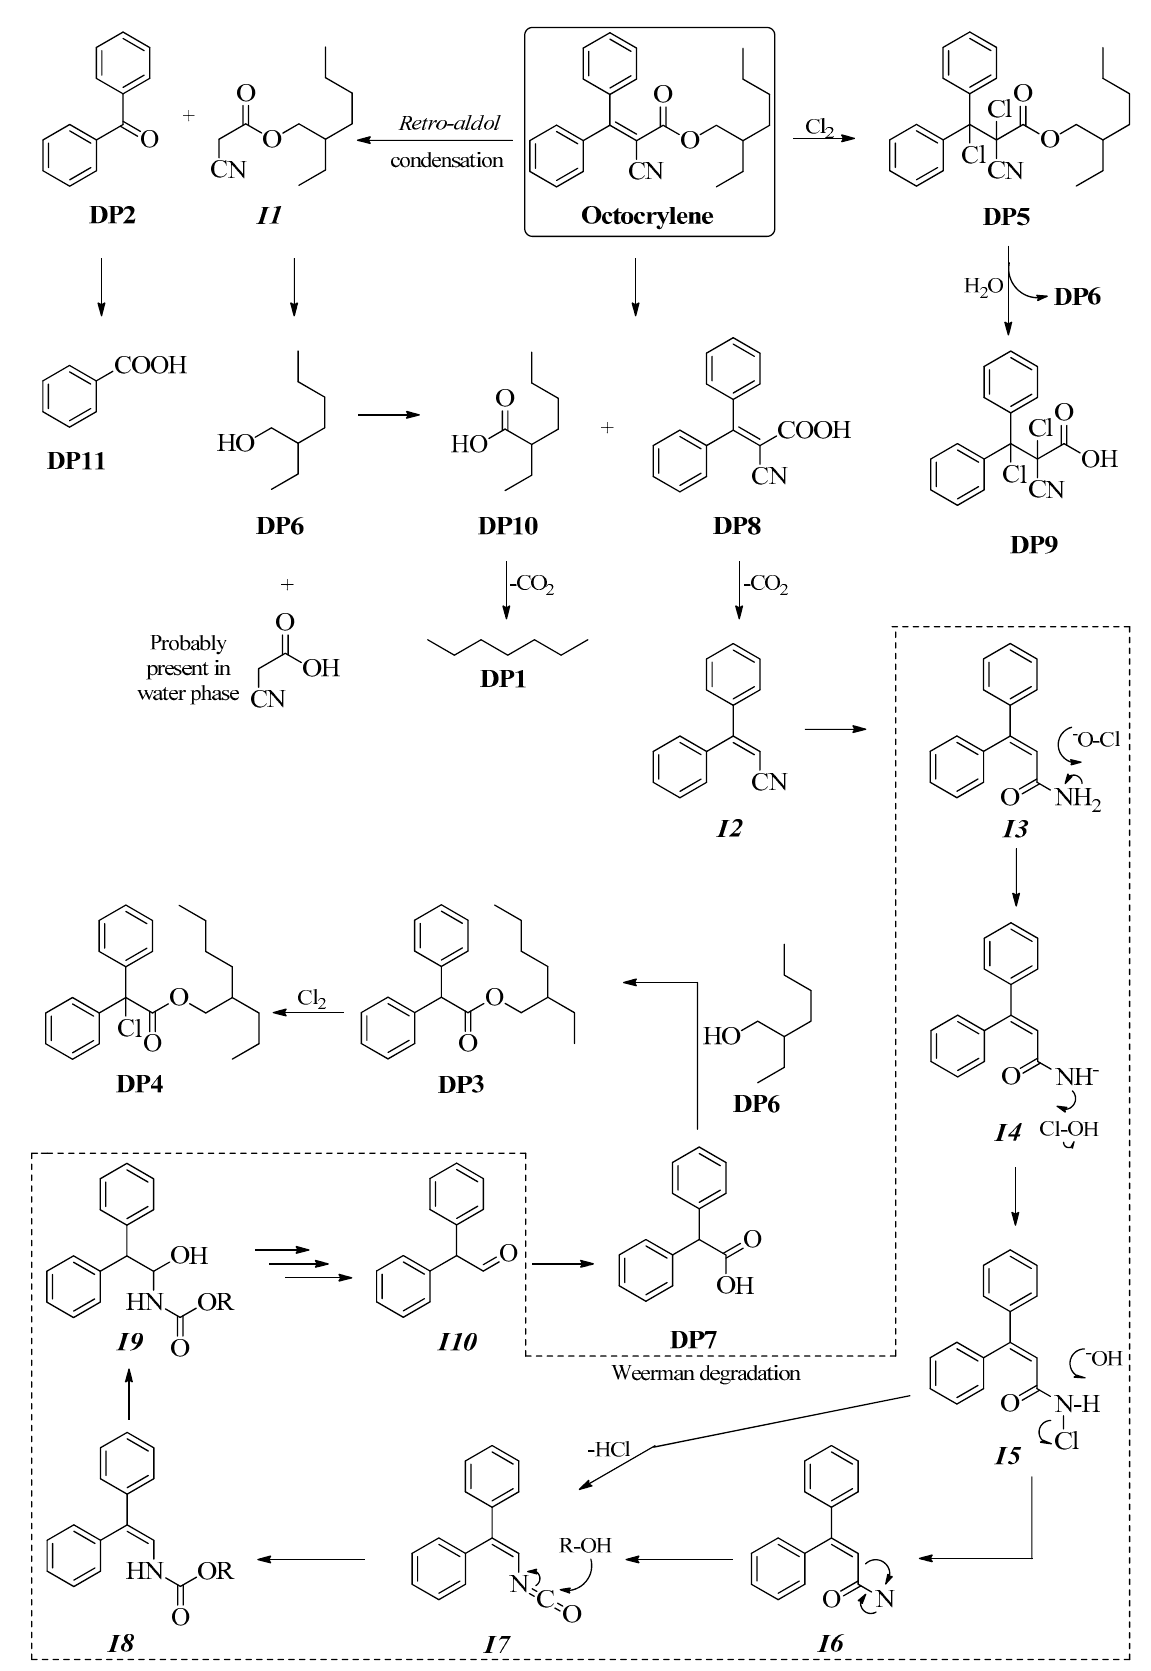
Figure 2. Plausible mechanism for the formation of DP1 - DP11 .